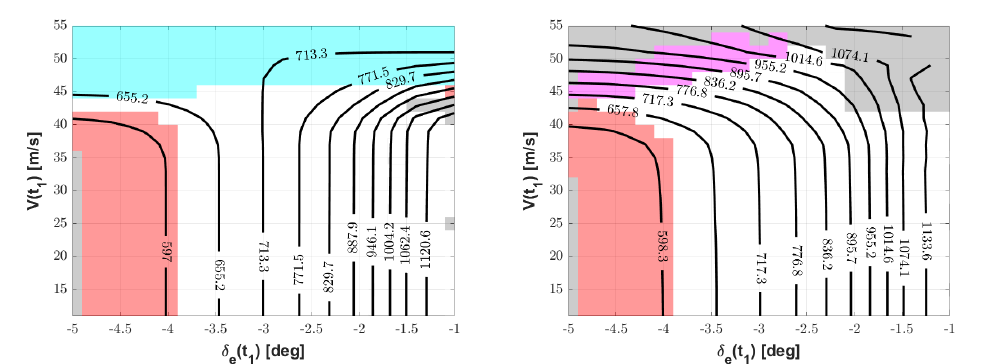
Figure 6. Take-off distance for the two-surface aircraft, as a function of V ( t 1 ) and δ e ( t 1 ) , for different assigned δ e ( t 0 ) . ( Left ): δ e ( t 0 ) = − 3 deg. ( Right ): δ e ( t 0 ) = +5 deg. Red area: tail strike. Purple area: excessive pitch rate. Cyan area: take-off before control pull-up. Grey area: two or more constraints